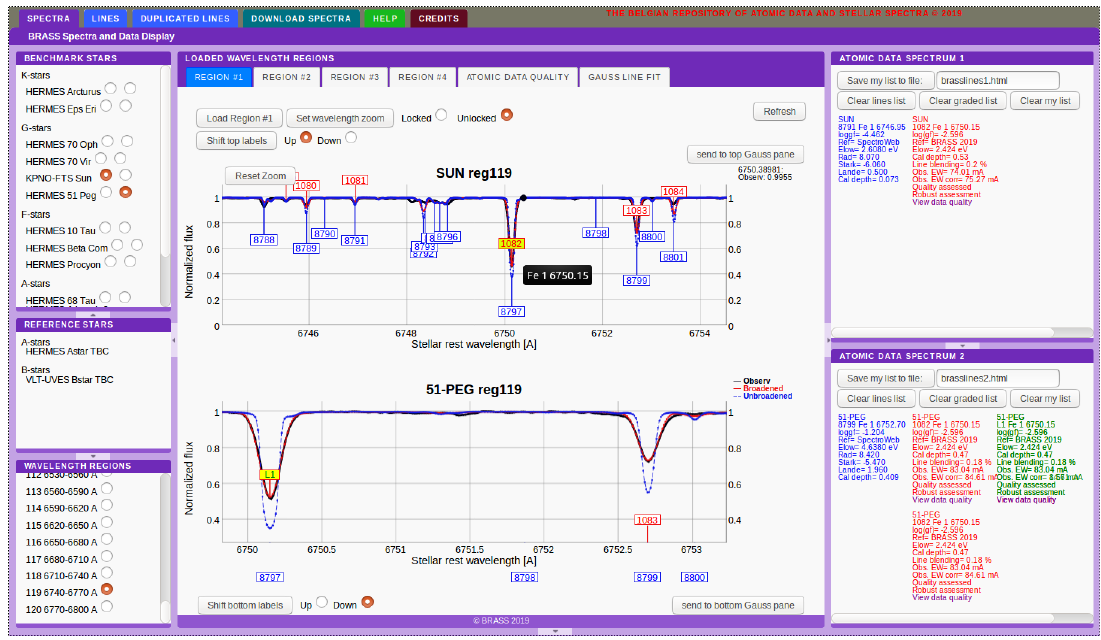
Figure 3. Screencopy of the SBDI for the solar FTS spectrum (central top panel) and the BRASS benchmark HERMES spectrum of the solar-like star 51 Peg (central bottom panel). The red and blue interactive labels mark identified absorption lines with atomic and line property data tables shown in the right-hand sub-panels. Atomic quality assessment pages are displayed under the central Atomic Data Quality tab by clicking on the View data quality link in the red or green line data